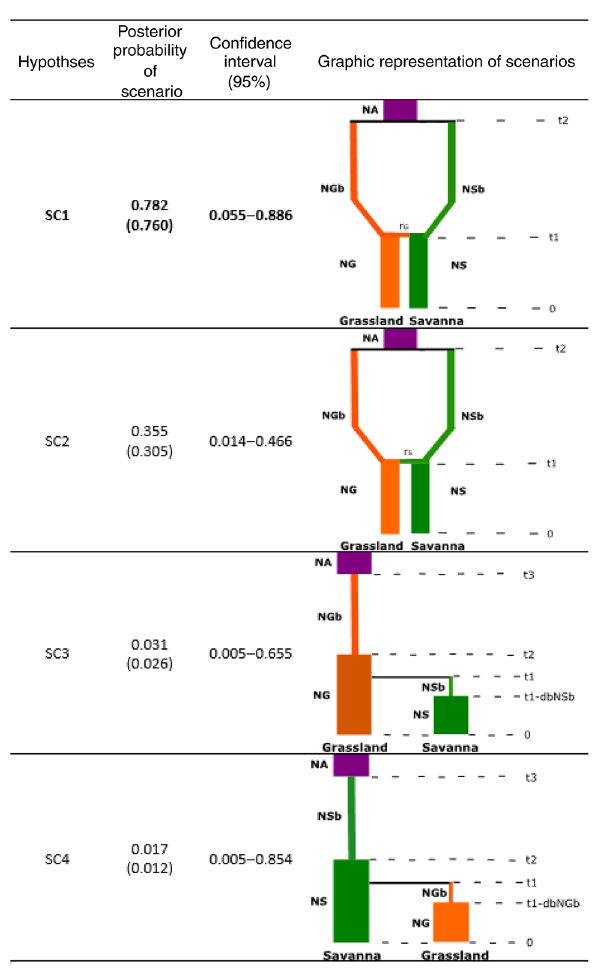
Table 6. ABC comparison between the hypothesized evolutionary scenarios. Bayesian posterior probabilities (direct and logistic regression in brackets) approaches, 95% credible interval (95% CI), and schematic representation of each tested scenario estimated using DIYABC for D. vittatus populations located in two Argentinean Biomes. The most probable scenario is highlighted in bold letters. NA: effective size of ancestral population, NS: effective size of Savanna, NG: effective size of Grassland, NGb: effective size of Grassland prior to population increase, NSb: effective size of Savanna prior to population increase, t: time in number of generations (generation time in D. vittatus is estimated in 1 year), r: admixture rate. Bar widths in the schematic representations of models are proportional to effective population size (indicating reductions and expansions ranging of the previous size). Gray bars represent divergence